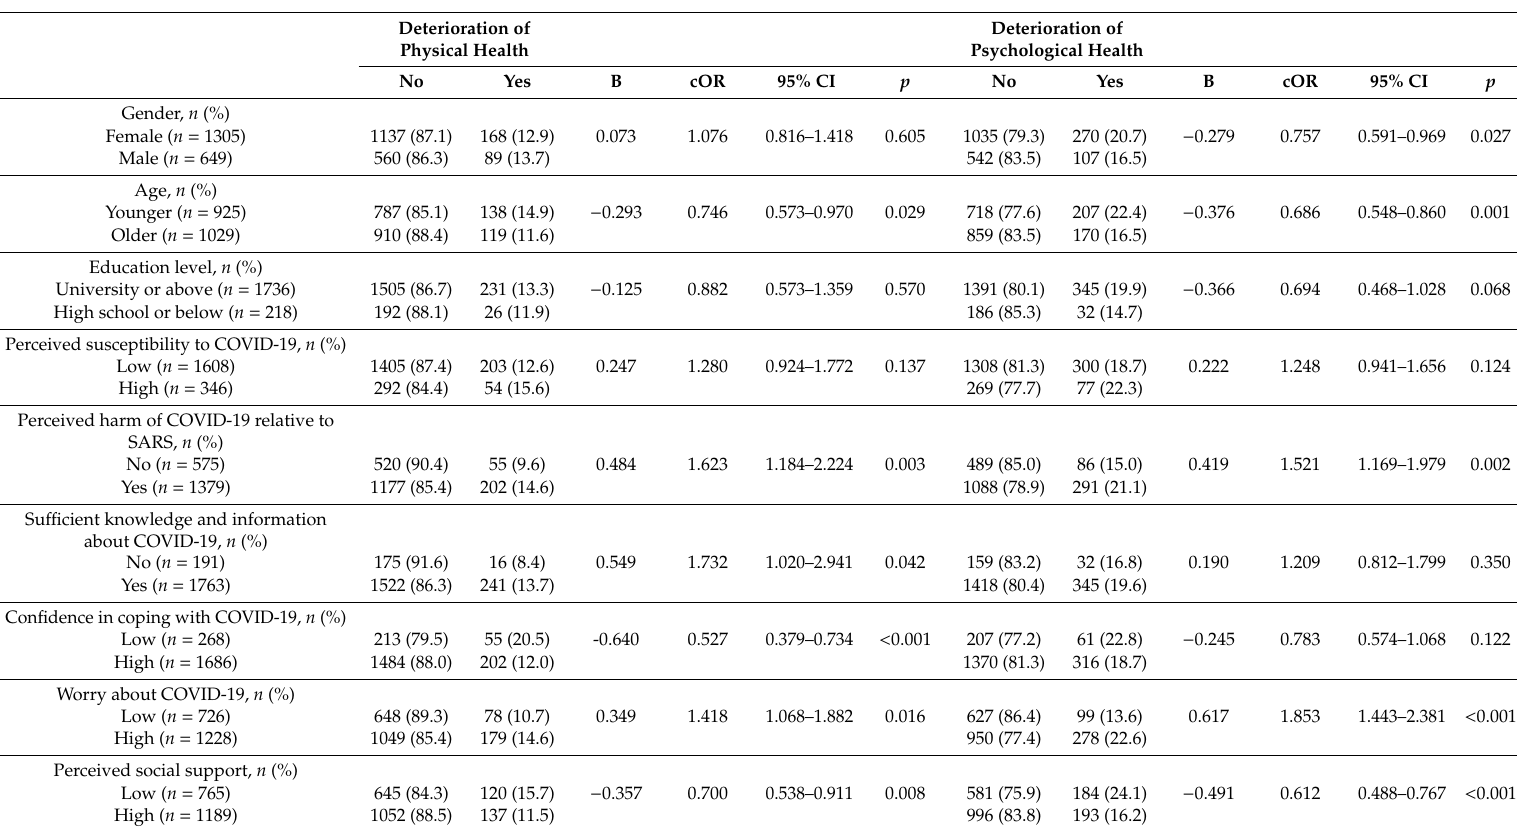
Table 2. Comparisons of demographic characteristics and cognitive and a ff ective health beliefs of COVID-19 between respondents with and without the deterioration of physical and psychological health: univariate logistic regression model (N =